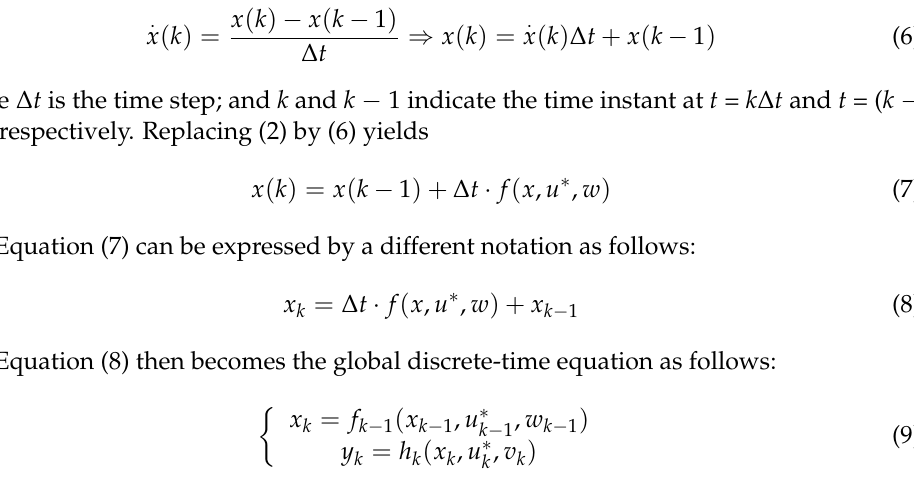
Figure 3. Regression curve from measured pressure vs. tire vertical stiffness (inset: zoomed view).